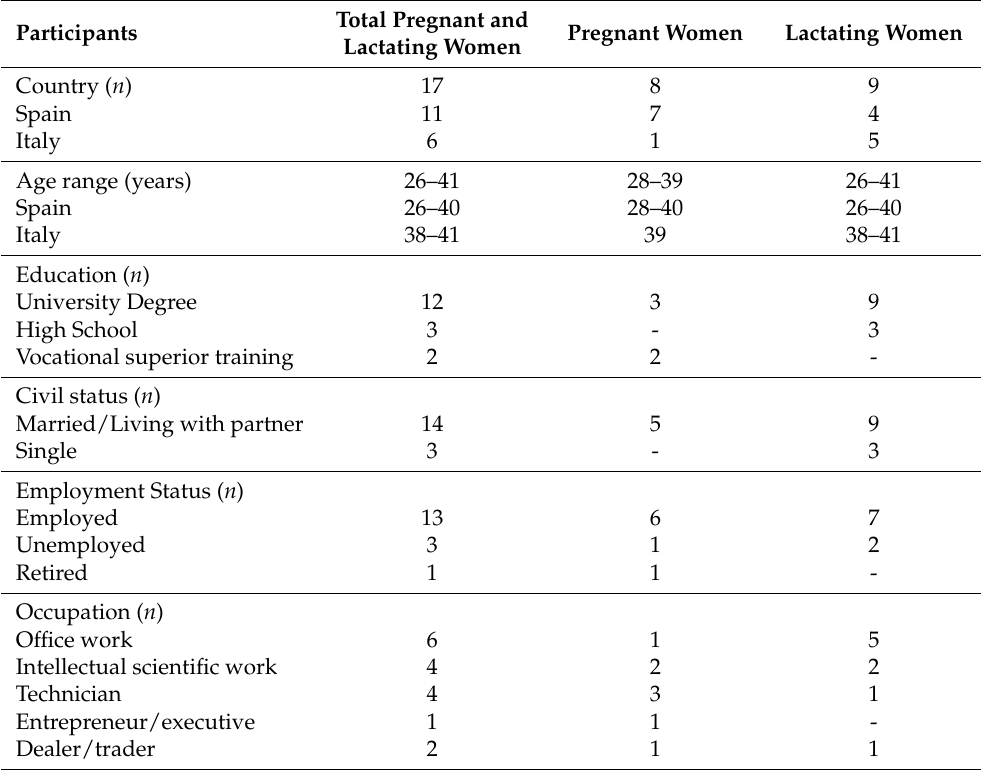
Table 1. Characteristics of the participants in Focus